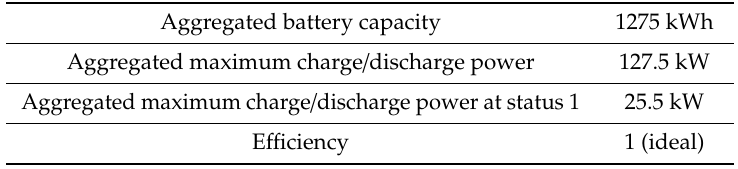
Table 1. Battery model data.